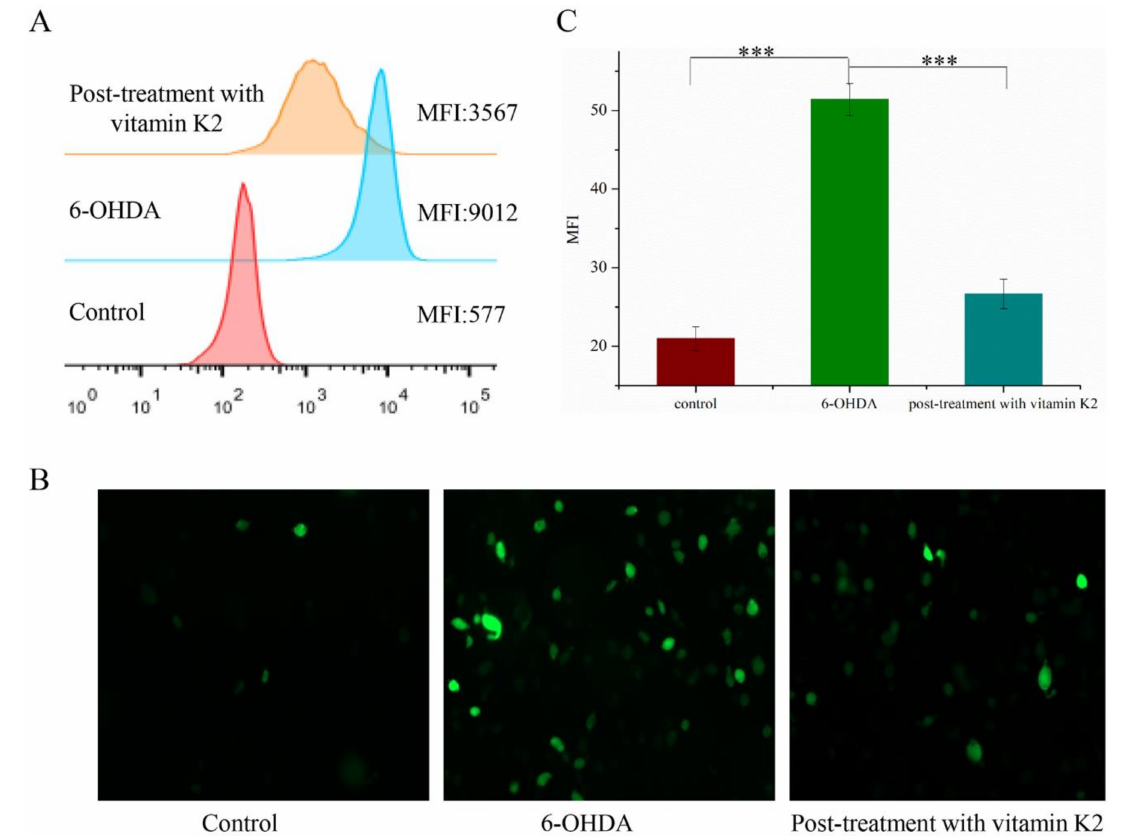
Figure 3. Analysis of reactive oxygen species level in SH-SY5Y cells. ( A ) Reactive oxygen species in cells were detected by flow cytometry. ( B ) Images of cells were taken by fluorescence microscopy. All images were taken with a 20 × objective. Images were taken in green modes, where green staining represents ROS. ( C ) Representative graphs of the mean fluorescence intensity (MFI) from three different visual fields of view, using the ImageJ software. The data are presented as mean ± SD ( n = 3). Significant difference *** p < 0.01 vs.